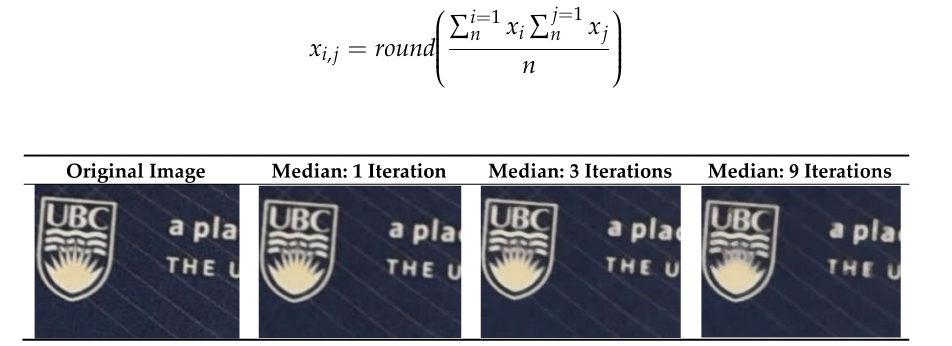
Figure A2. Comparison of the results between the original image from region D in Figure A1 to cases where the Median filter was applied at one, three and nine iterations.